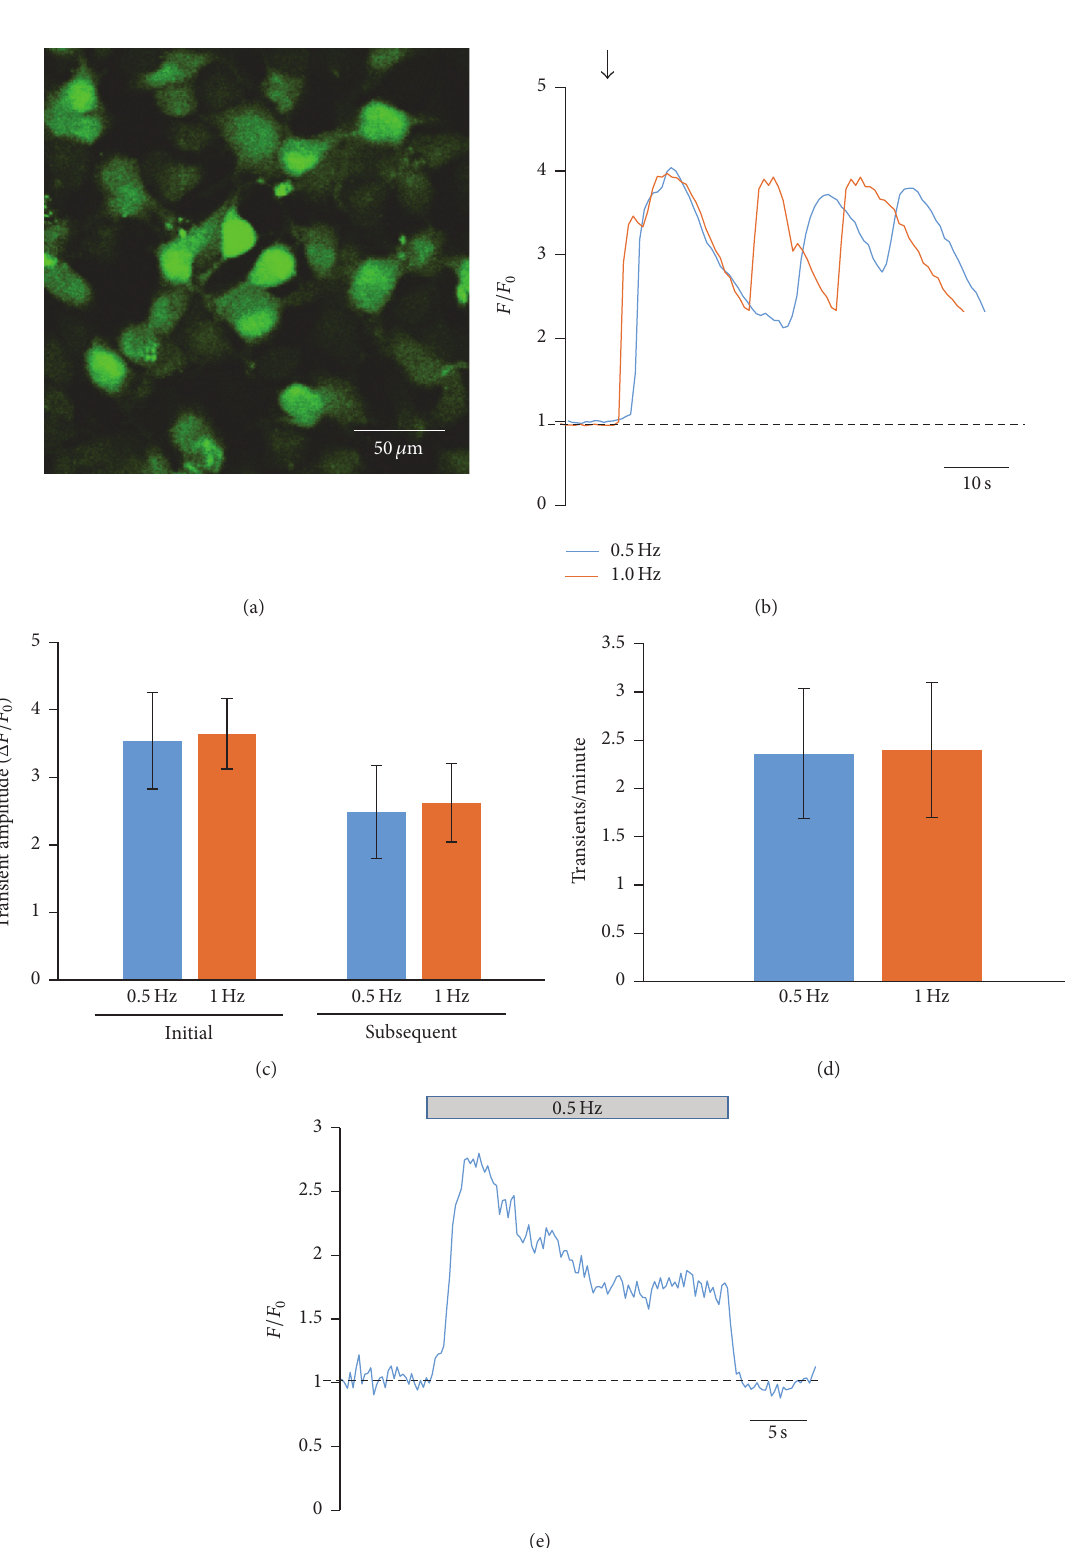
Figure 1: Whole-cell Ca 2+ oscillations in electrically stimulated CPCs. (a) 2D fluorescent image of child CPCs loaded with fluo-4/AM. Fluo- 4/AM-loaded hcCPCs were electrically stimulated at 0.5 Hz (blue) or 1Hz (orange). Representative recordings of Ca 2+ oscillations are shown in (b). The arrow indicates the start of electrical stimulation. The amplitude ( Δ𝐹/𝐹 0 ) and frequency (oscillations/minute) of the oscillations are summarized in (c) and (d), respectively. (e) Representative recording of cytosolic Ca 2+ before, during, and after 0.5 Hz electrical stimulation. The bar above the trace shows the time during the recording when electrical stimulation was applied. Data in (e) represent mean ± SD. No significance was found by Student’s 𝑡 -test. 𝑛 = 14 cells from 4 different pools of cells for all